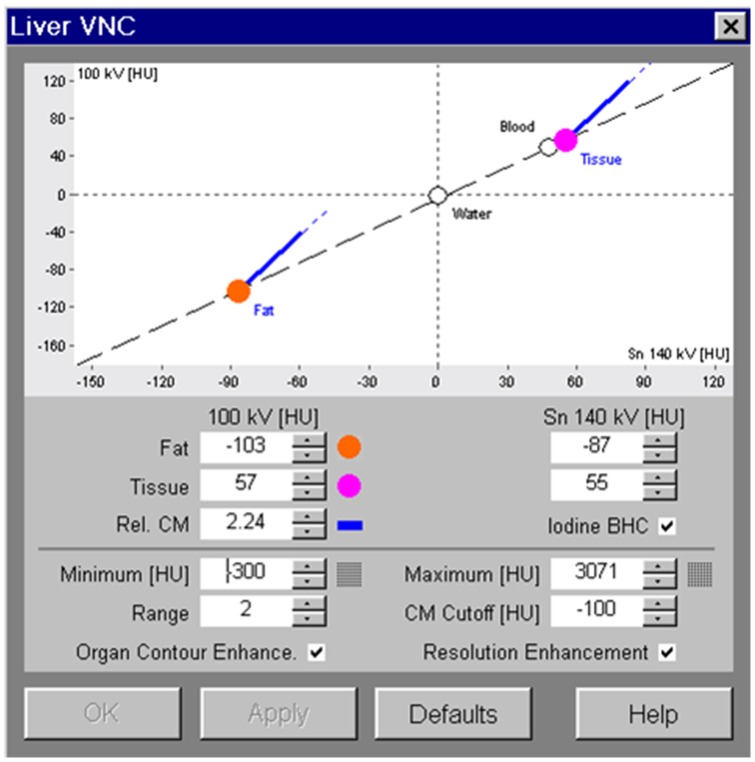
Standard values applied for analysis of soft-tissue and fat-tissue attenuation.